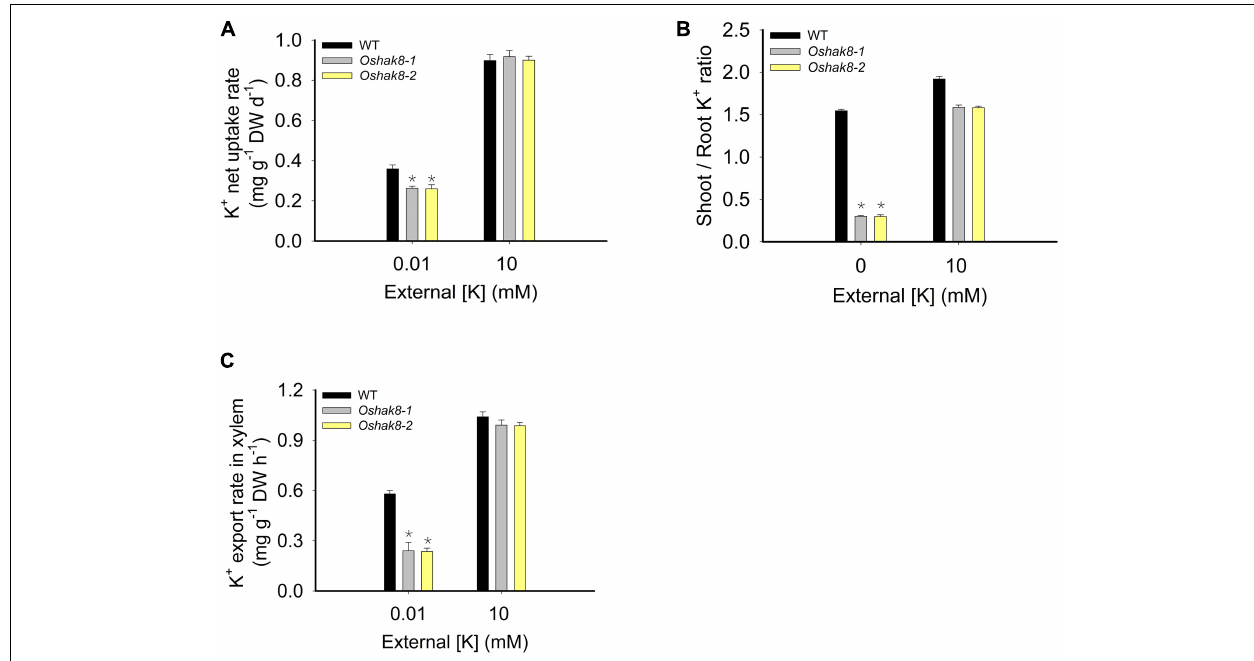
FIGURE 6 | Effects of Oshak8 knockout on K translocation under different K + -supply conditions. (A) K + net uptake rate of WT and Oshak8 mutant ( Oshak8 -1, Oshak8 -2) plants. The seeds of the WT and Oshak8 mutants were germinated in water for 5 days, transferred to the hydroponic solutions containing 10 mM of K + for 14 days, and then transferred to the hydroponic solutions containing 0 mM of K + for 5 days. For the K + uptake assay, K + -starved plants were incubated in the medium containing 0.01 or 10 mM of K + for 3 days and the roots and shoots were collected for K + content measurements using inductively coupled plasma analysis. (B) The shoot/root ratios of K + in various plant materials. Growth conditions were as described in Figure 2 . The roots were collected for K + content measurements using inductively coupled plasma analysis. (C) K + export rate in the xylem. Seven-day-old rice seedlings were grown in the International Rice Research Institute (IRRI) solution for 2 weeks and then transferred to 10- or 0.01-mM K + solutions for 2 weeks before the sampling. The detailed protocols for the shoot excision, collection of the xylem sap by cotton ball, determination of K + concentration by ICP, and calculation of the xylem K + export rate were described previously by Yang et al. (2014). K + contents were determined by ICP-AES. Significant differences were found between WT and Oshak8 mutants ( Oshak8-1 , Oshak8-2 ) (* P < 0.01 by Student’s t -test). Data are means of three replicates of one experiment. The experiment was repeated three times with similar results. Error bars represent ± SD. Asterisks represent significant differences. DW, dry